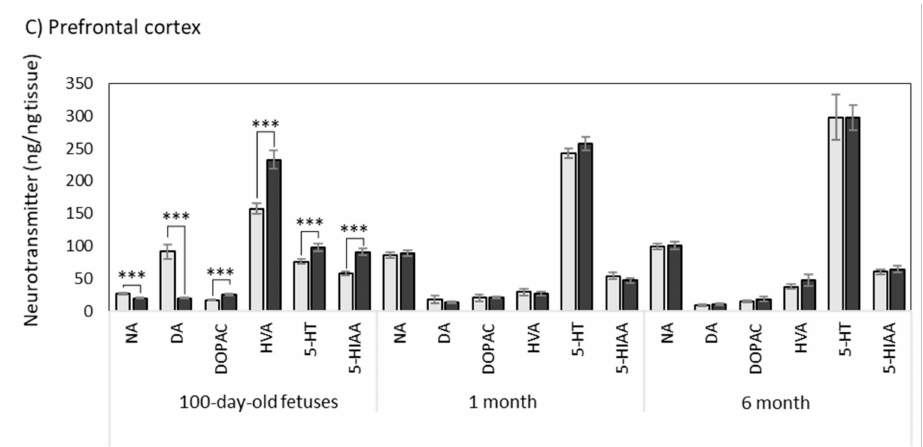
Figure 1. Effect of maternal supplementation with HTX on the concentration of neurotransmitters in the amygdala ( A ), hippocampus ( B ), and prefrontal cortex ( C ) of 100-day old fetuses and 1-month- and 6-month-old pigs. Values in bars (mean ± SE, ng/g tissue) represent noradrenaline (NA), dopamine (DA), 3,4-dihydroxyphenylacetic acid (DOPAC), homovanillic acid (HVA), serotonin (5-HT), and 5-hydroxyindole-3-acetic acid (5-HIAA). Light bars represent results from the control groups, and dark bars represent results from individuals whose mothers were treated with HTX. Asterisks indicate significant differences between the control group and the HTX group for the respective ages (*** p < 0.001, ** p < 0.01, * p <